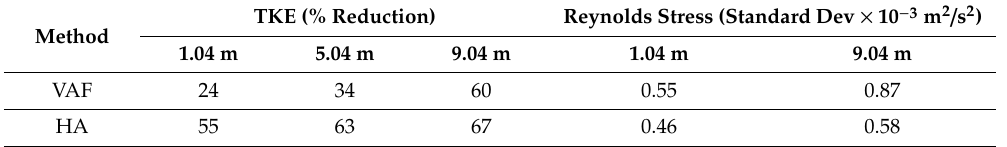
Table 1. Performance indicators of wave-removal methods in the estimates of turbulence parameters at different distances from the bottom. The HA method was more effective in reducing wave-related values of Turbulent Kinetic Energy (TKE) and Reynolds stress than the VAF method.